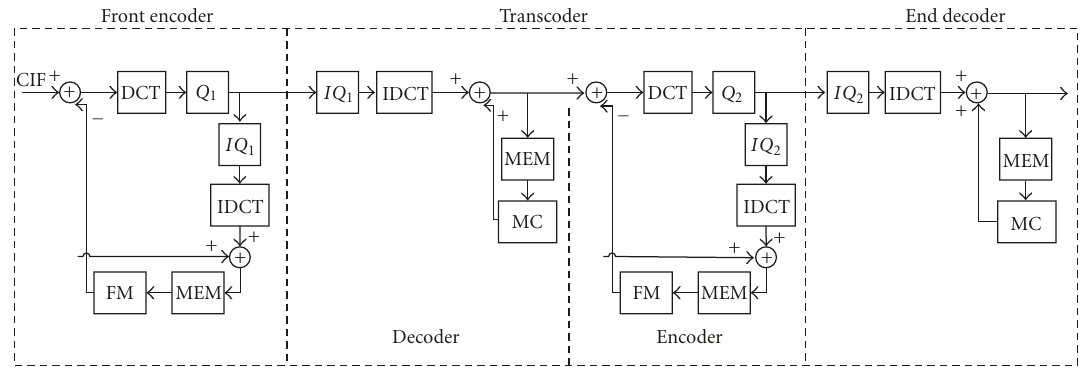
Figure 1: A straightforward realization of video transcoder.